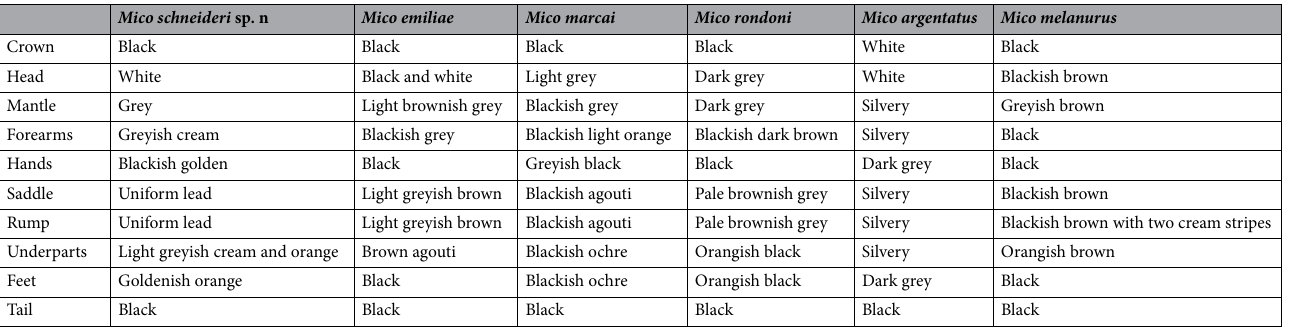
Table 1. Pelage colour characters from chromogenetic fields and their states in Mico schneideri sp. n. and in the morphologically and phylogenetically close related species.